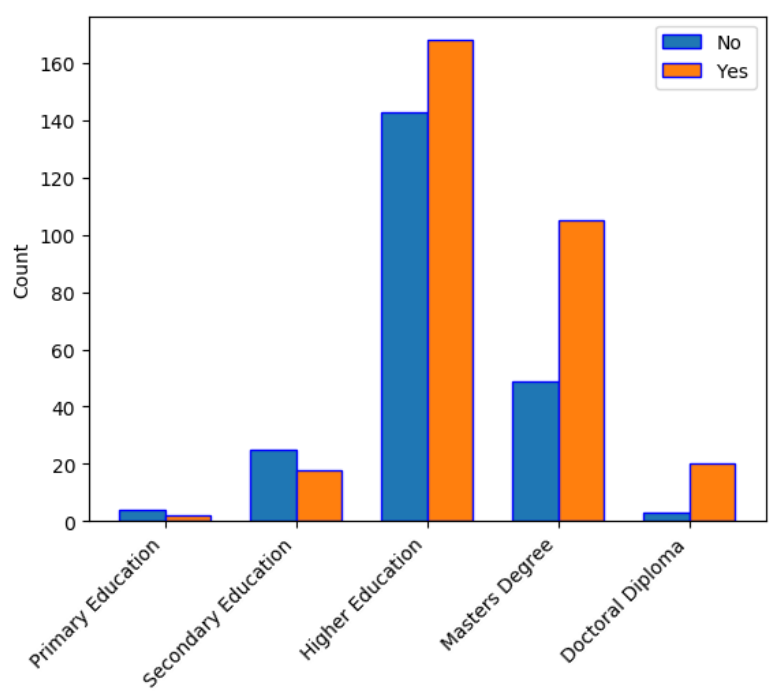
Figure 8. Education level for non-familiar